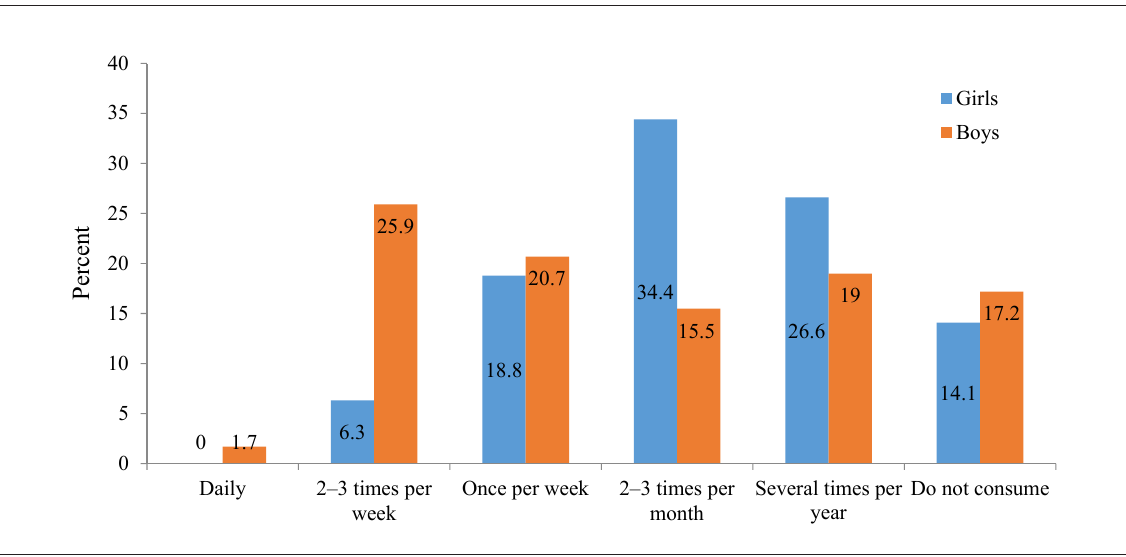
Note. χ 2 = 13.89 ; lls = 5; p = .02. Figure 1. Frequency of beer consumption according to gender Figure 2. Frequency of wine consumption according to